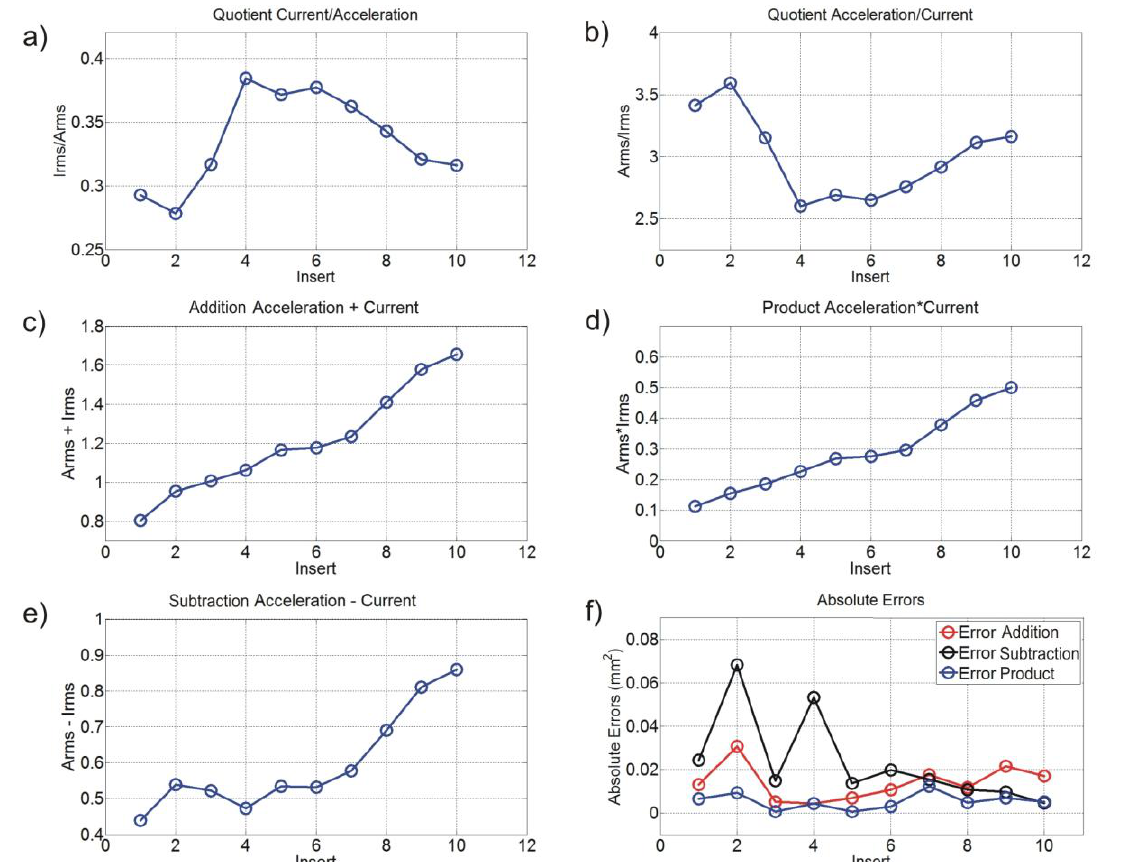
Figure 6. Exploration of weighting function